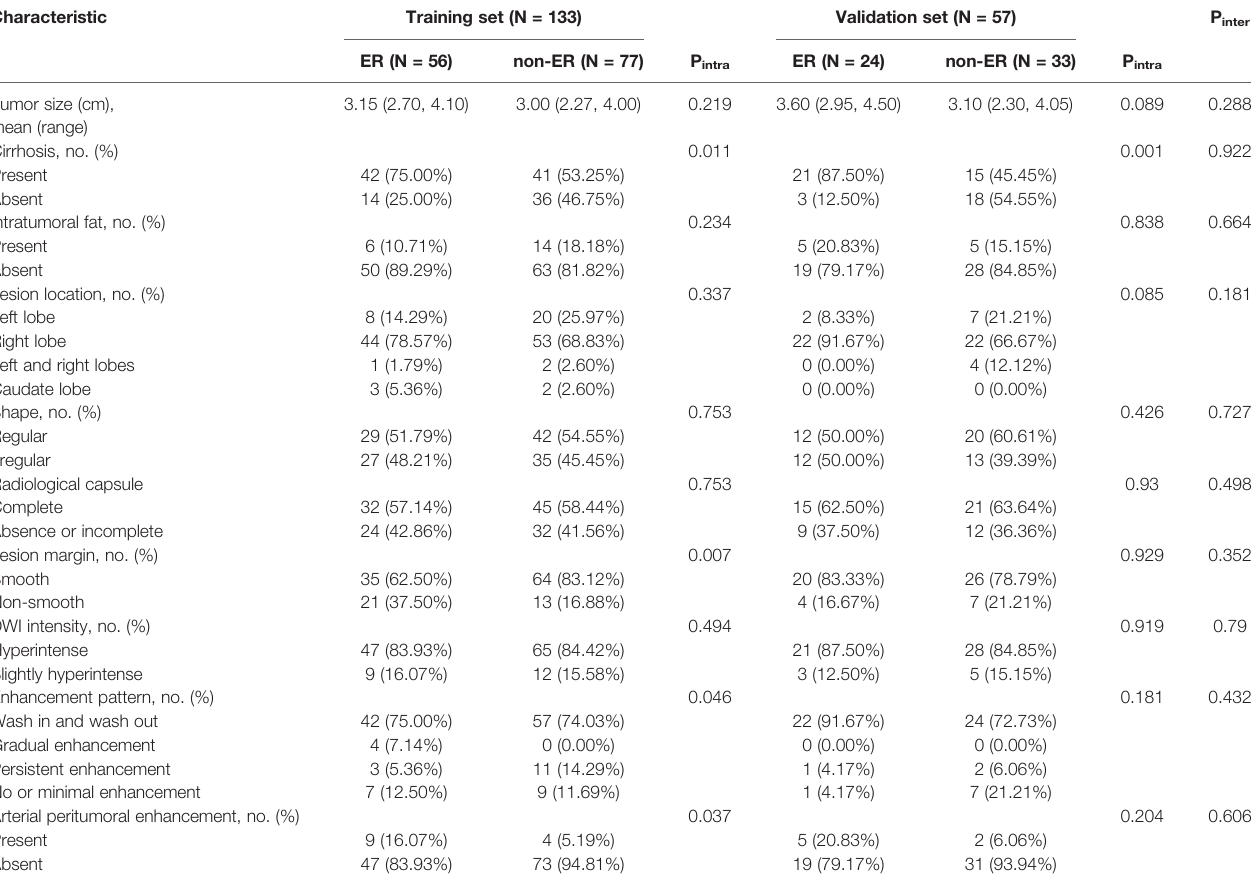
TABLE 1b | Comparisons of radiological features in the training and validation sets.